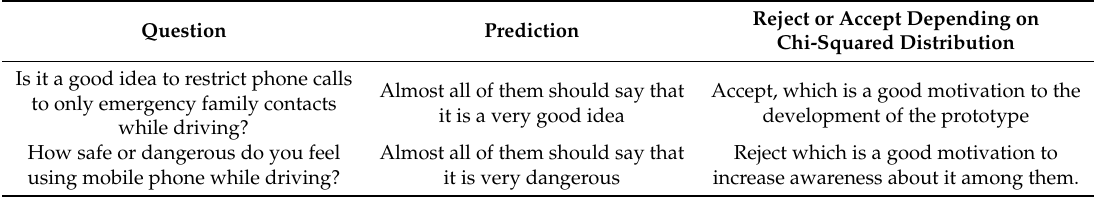
Table 2. Chi-Squared distribution results for two major survey